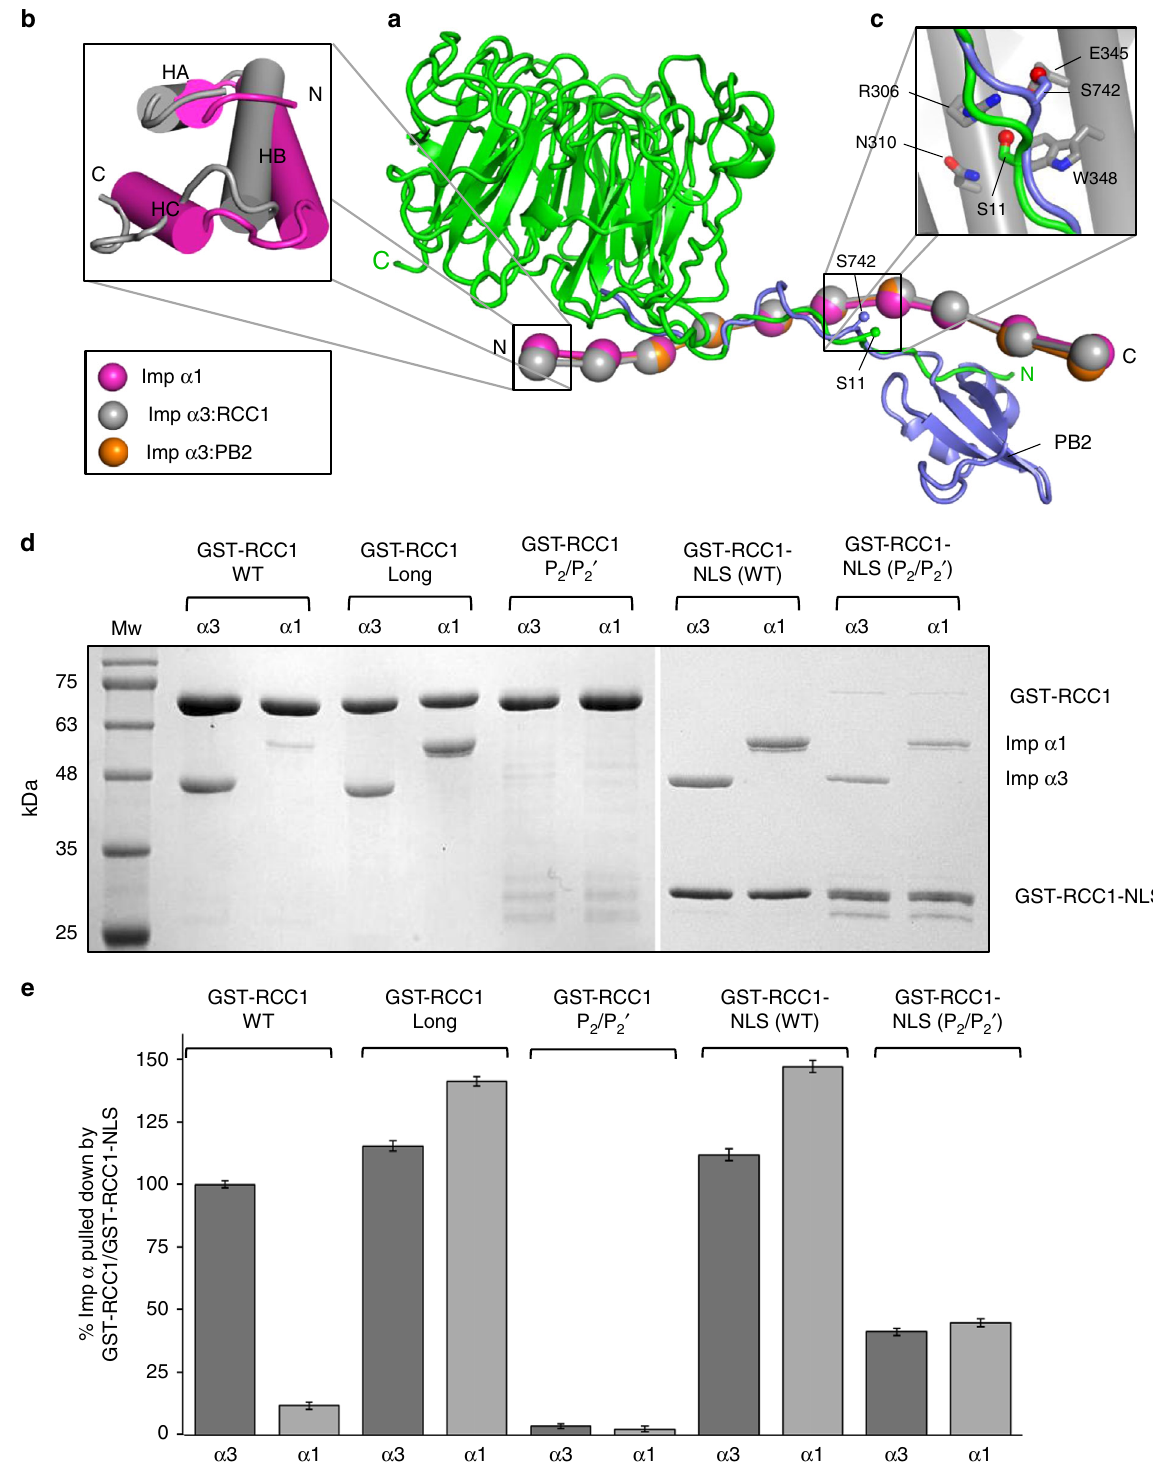
Fig. 4 Structural fl exibility in importin α 3 promotes RCC1 recognition. a Structural superimposition of importin α 3:RCC1 (pdb: 5TBK), importin α 3:PB2 (pdb: 4UAE), and importin α 1:nucleoplasmin NLS (pdb: 1EJY). Importin α s are shown as beads-on-a-string (each bead representing an Arm repeat 31 ) while PB2 and RCC1 are displayed as ribbons; the nucleoplasmin NLS is omitted for clarity. b Zoom-in panel showing a superimposition of Arm 1 in importin α 3 bound to RCC1 ( gray ) and importin α 1 ( magenta ). c Zoom-in panel showing the local environment of the RCC1 S11 and PB2 S742, which are both subjected to phosphorylation. d Pull-down analysis of the interaction of importin α 3 and α 1 with the full-length GST-RCC1, GST-RCC1-Long, GST-RCC1-P 2 /P 2 ′ or just the RCC1-NLS (e.g., GST-RCC1-NLS (WT) and GST-RCC1-NLS (P 2 /P 2 ′ )). The gel shows identical fractions eluted from glutathione beads. Loading controls are in Supplementary Fig. 3b. e Quanti fi cation of pull-downs in d shown as mean ± SD for three independent experiments. No interaction was observed between free importin α 1/3 and glutathione beads (Supplementary Fig.